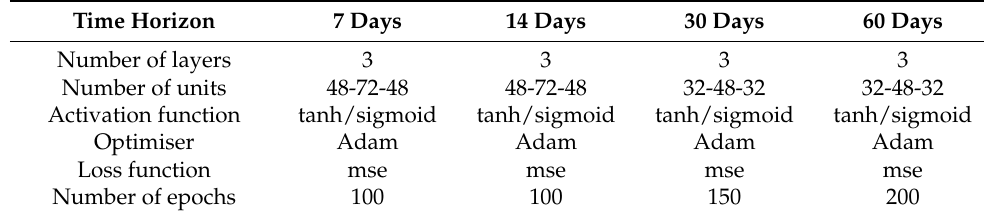
Table 3. Hyper-parameters of the models for different time horizons. Time Horizon 7